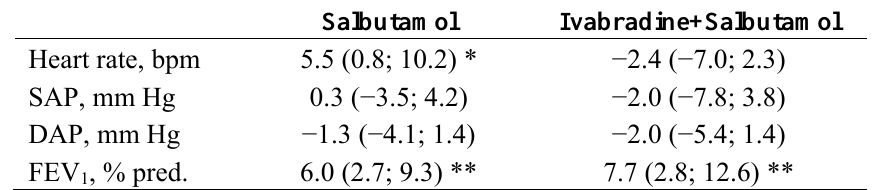
Table 3. Changes after salbutamol inhalation versus combination